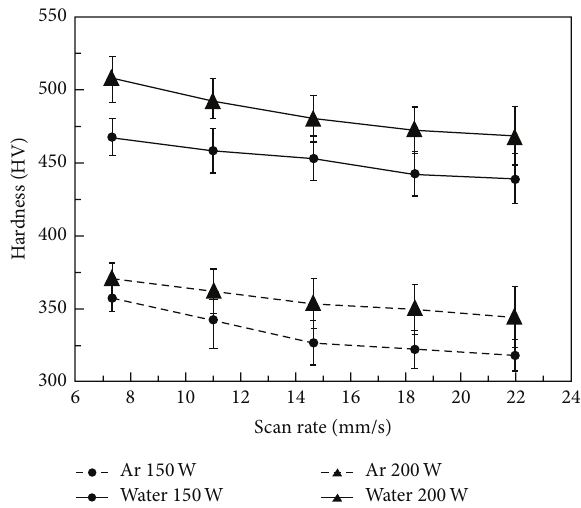
Figure 9: Comparisons of laser scan rate effects on microhardness of laser hardened